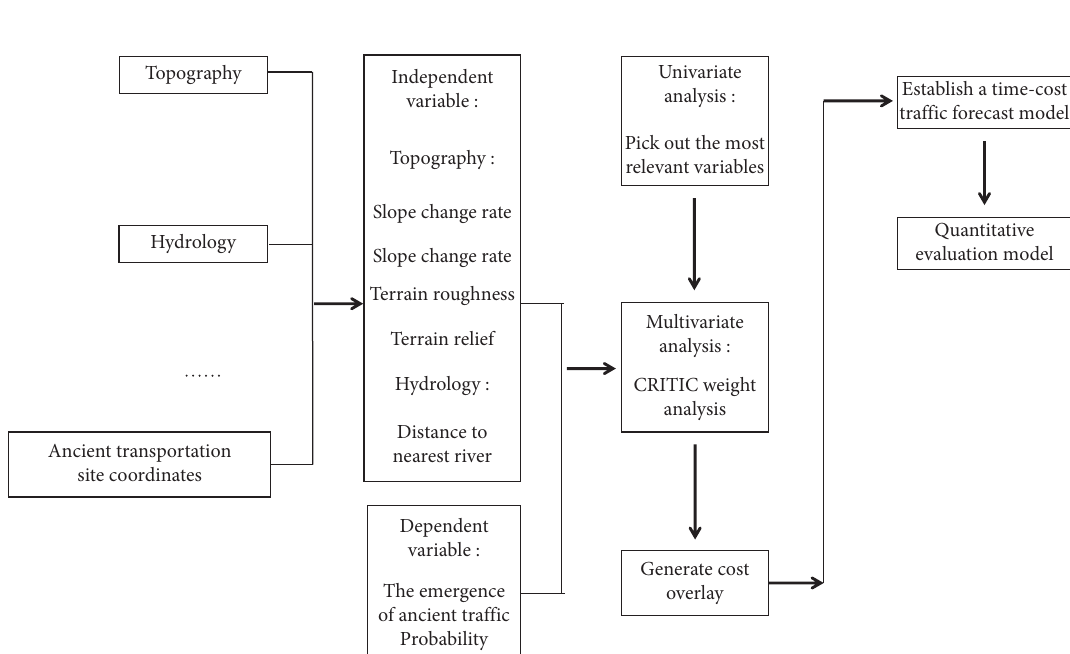
Figure 3: Construction of ancient military road prediction